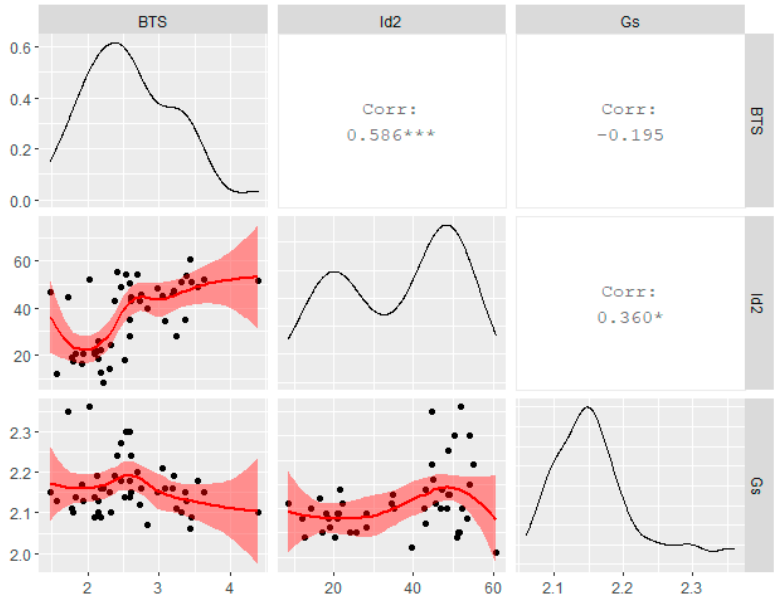
Figure 2. Scatterplot and the probability plots of the three variables.